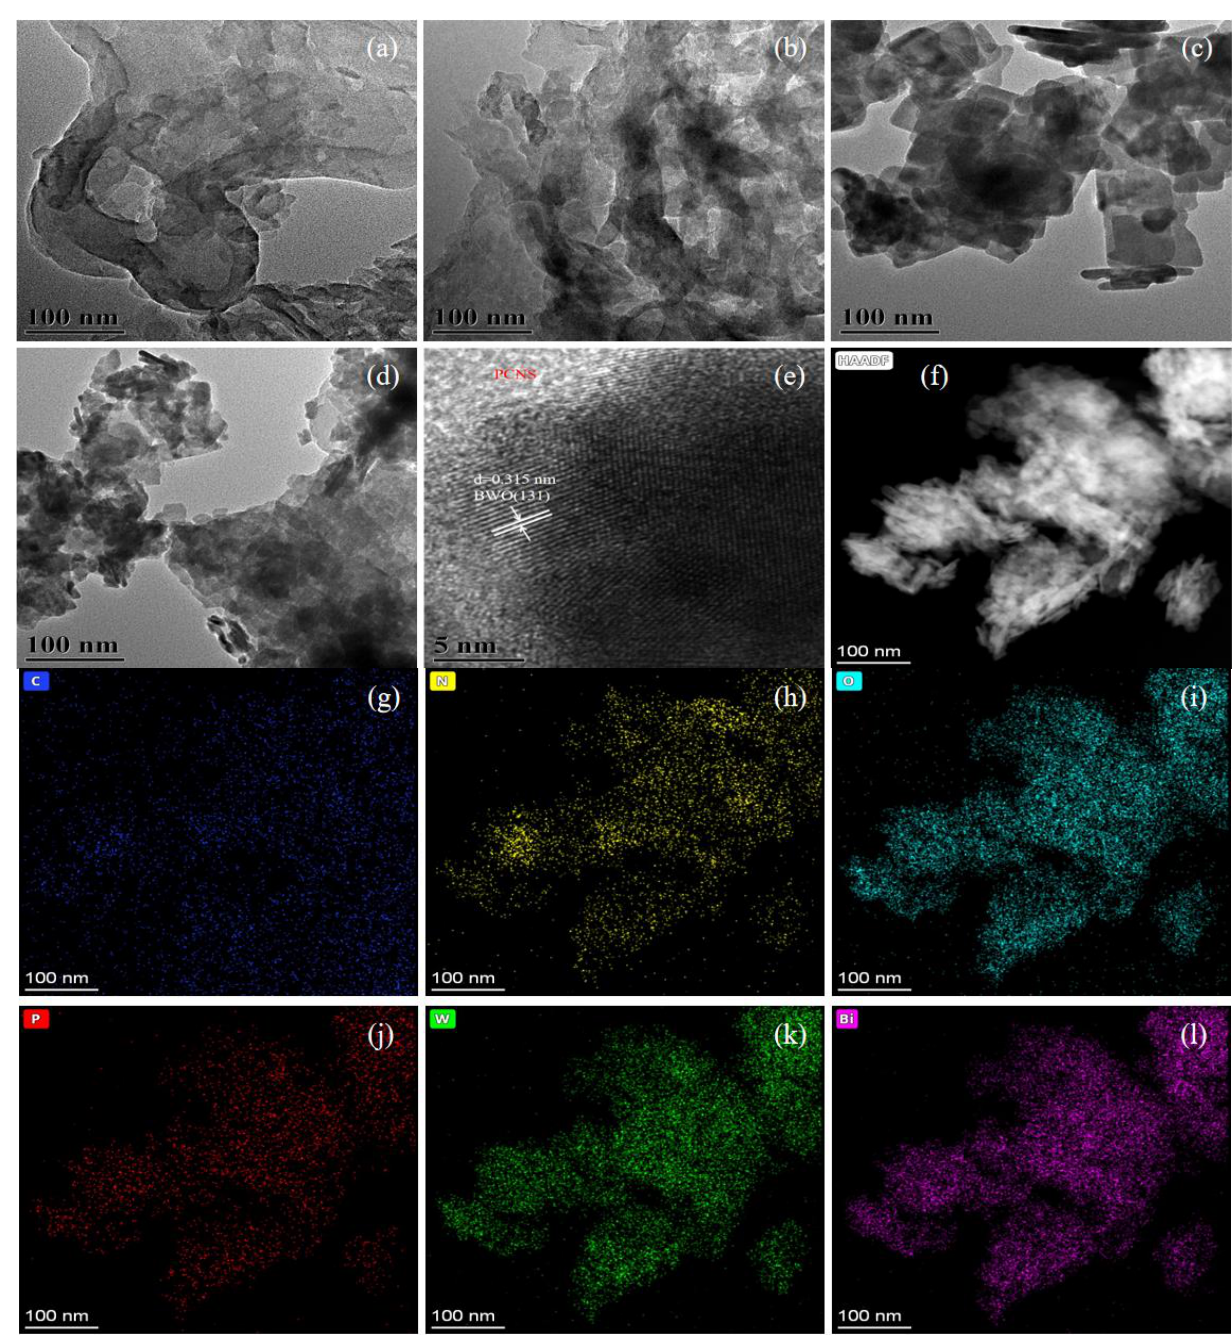
Figure 5. TEM images of ( a ) CNS, ( b ) PCNS, ( c ) BWO, and ( d ) 30% PCNS/BWO; ( e ) HRTEM image and ( f ) HAADF image of 30% PCNS/BWO; ( g – l ) EDS maps of the area in ( f ).